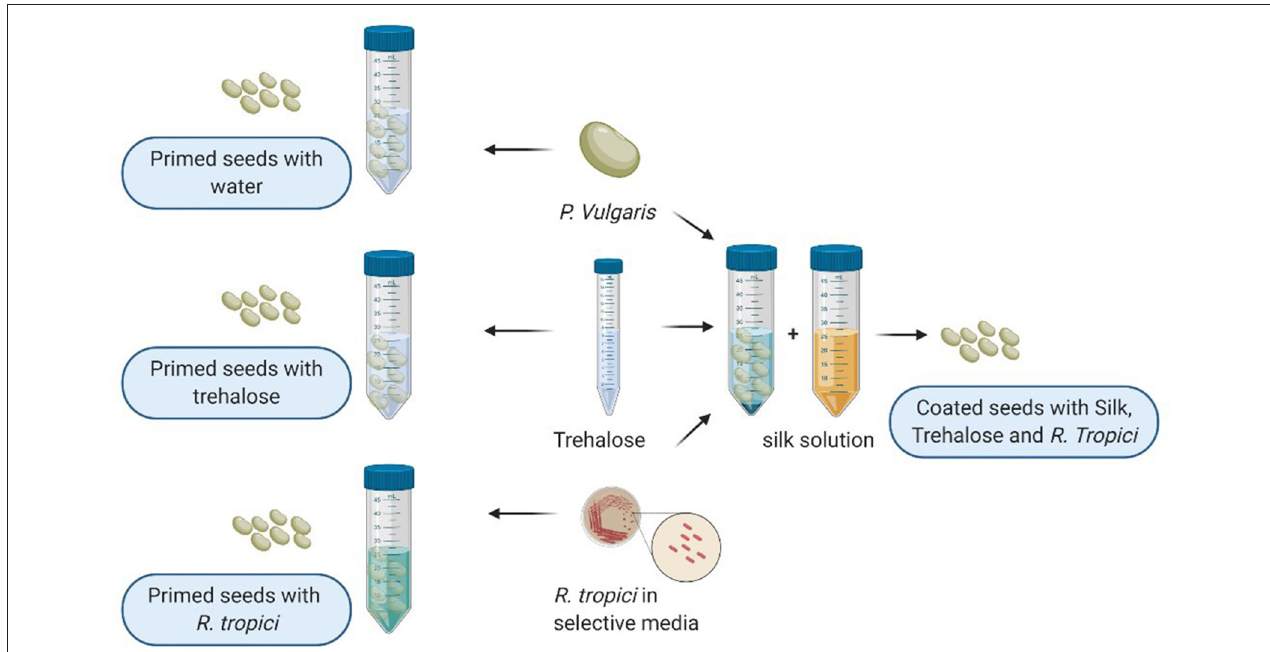
FIGURE 1 | Illustration of seed priming and seed coating protocol created with BioRender.com.